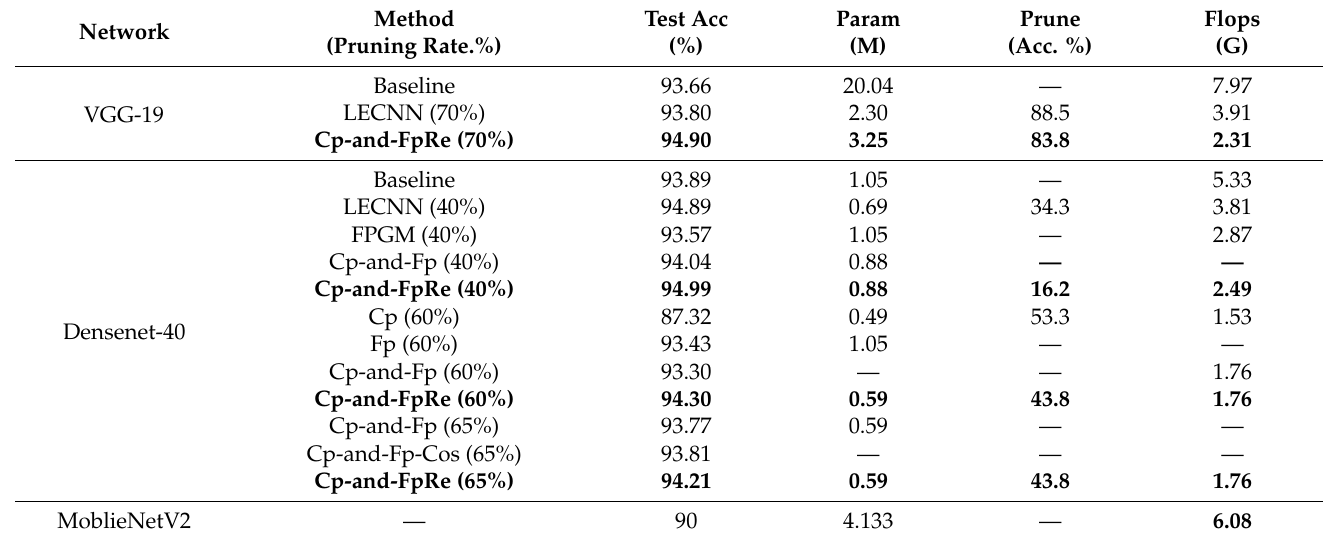
Table 1. Comparison of pruning effects of models VGG19 and DenseNet40 on CIFAR10 dataset. Network